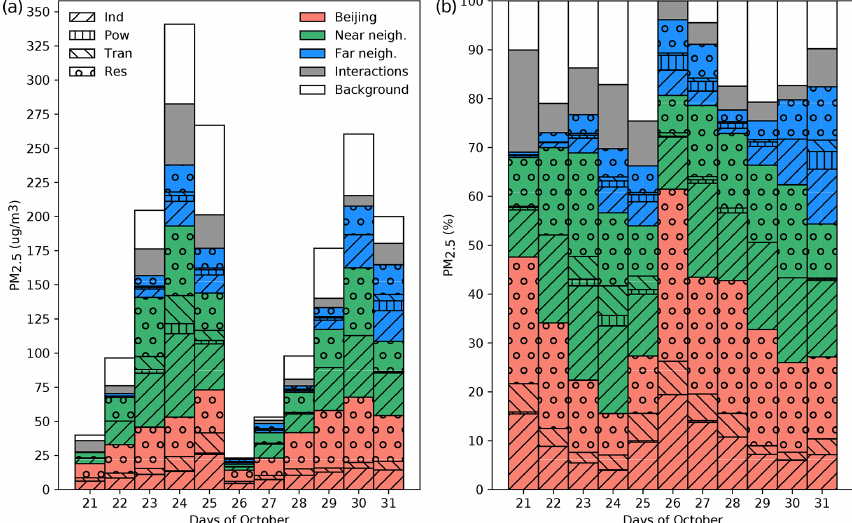
Figure 7. Absolute (a) and relative (b) contributions to daily mean PM 2 . 5 in Beijing for 21–31 October obtained by removing one emission sector from one region at a time. Contributions from the three regions are shown in different colours and those from the four sectors are shown with distinct patterns. Contributions from other sources are shown in white and contributions due to interactions between emissions from different sectors are shown in